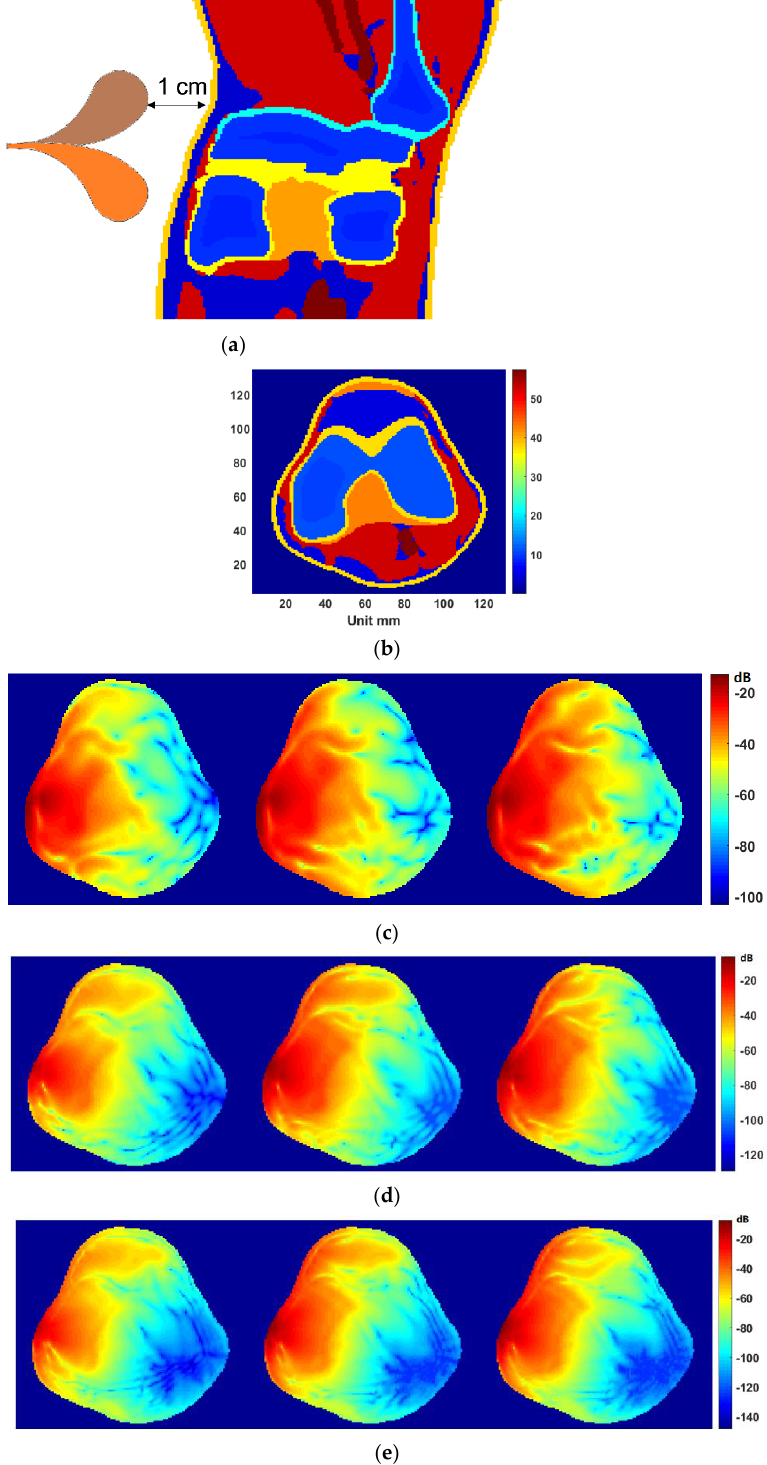
Figure 6. Electromagnetic field in a knee. ( a ) Measurement setup with an antipodal Vivaldi antenna. ( b ) a slice in the trans − axial plane extracted from the 3D knee model. ( c ) From left to right: 3 GHz field in the slice shown in ( b ) when the knee is exposed in air, 99% isopropyl, and in glycerin, respectively. ( d ) From left to right: 5 GHz field in the slice shown in ( b ) when the knee is exposed in air, 99% isopropyl, and in glycerin, respectively. ( e ) From left to right: 7 GHz field in the slice shown in ( b ) when the knee is exposed in air, 99% isopropyl, and in glycerin,